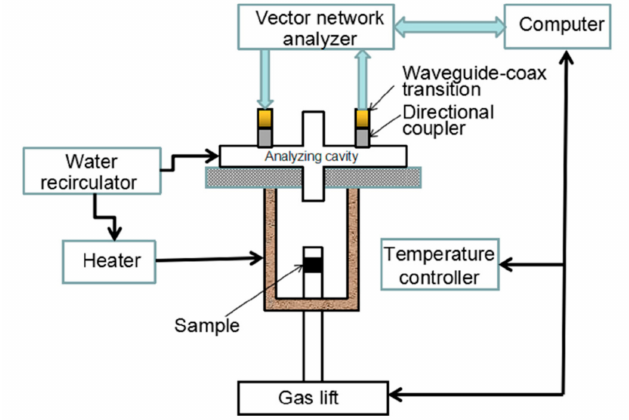
Figure 2. Schematics of the permittivity measurement